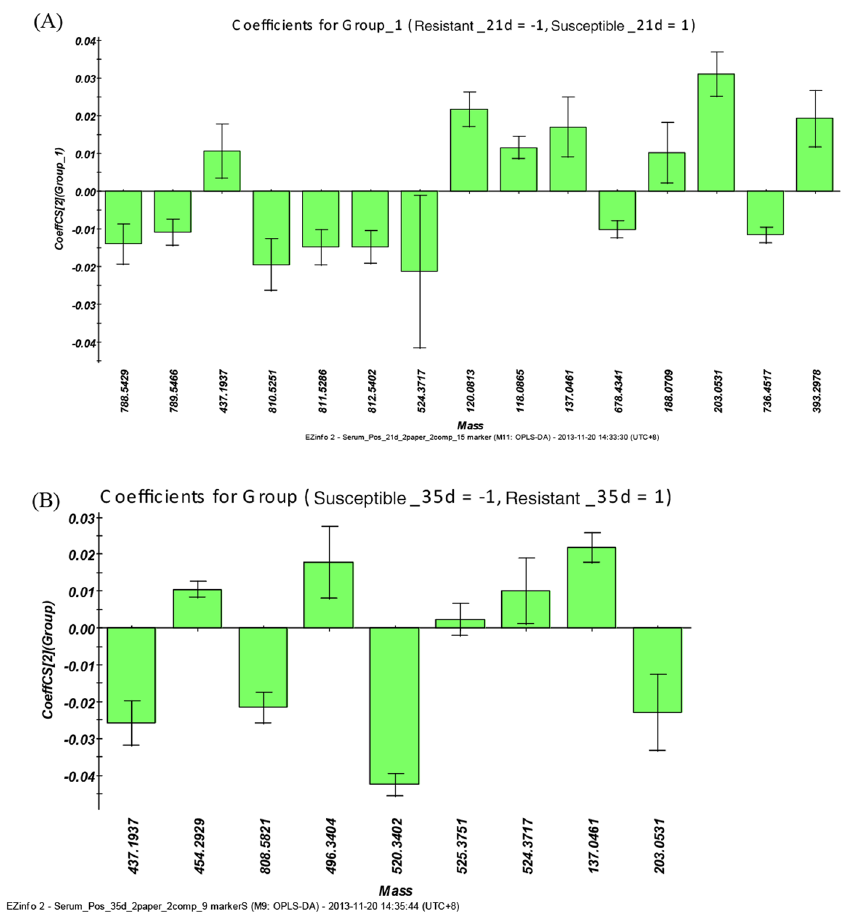
Figure 9. OPLS-DA loading plot in positive ion mode from the resistant group and susceptible group on day ( A ) 21 and ( B ) 35. The loading plots represent which metabolites are quantitatively higher or lower in suspectible group compared with resistant group.